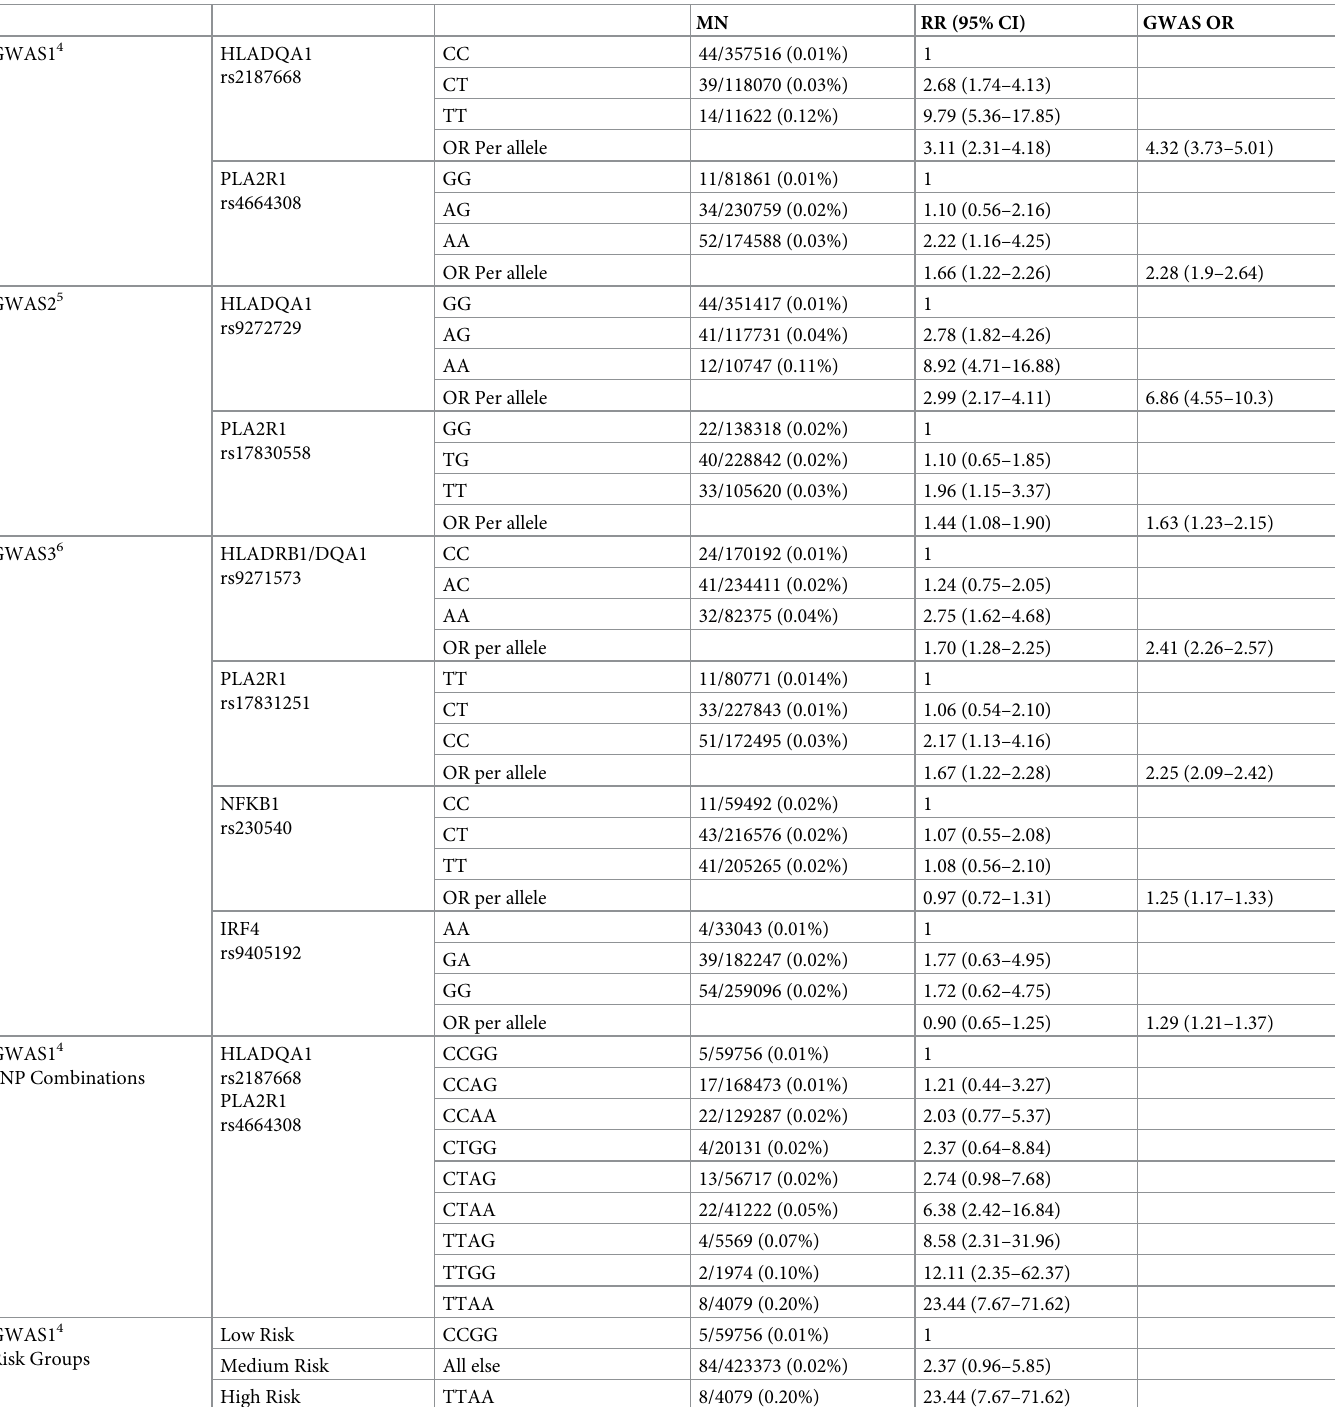
Table 4. Genetic risk analysis in the membranous nephropathy cohort using the lead SNPs from GWAS1 4 , GWAS2 5 and GWAS3 6 from the imputed UK Biobank